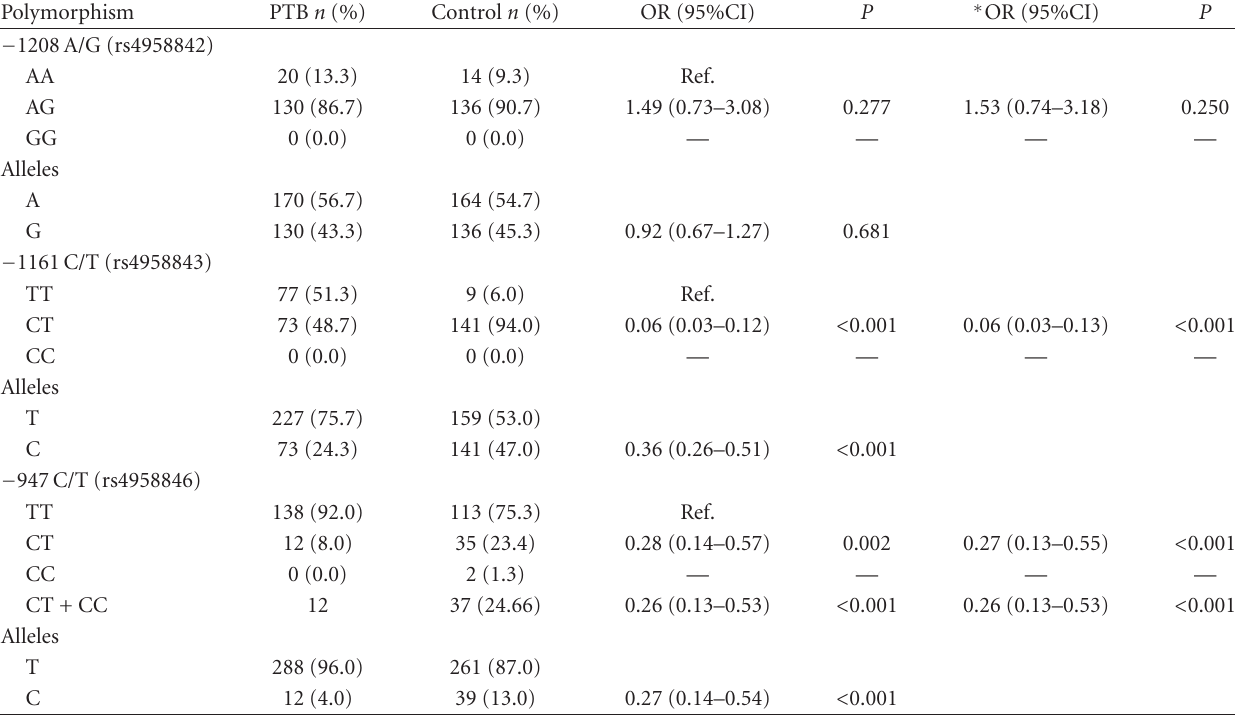
Table 2: The genotypes and allele distribution of IRGM polymorphisms in case and control